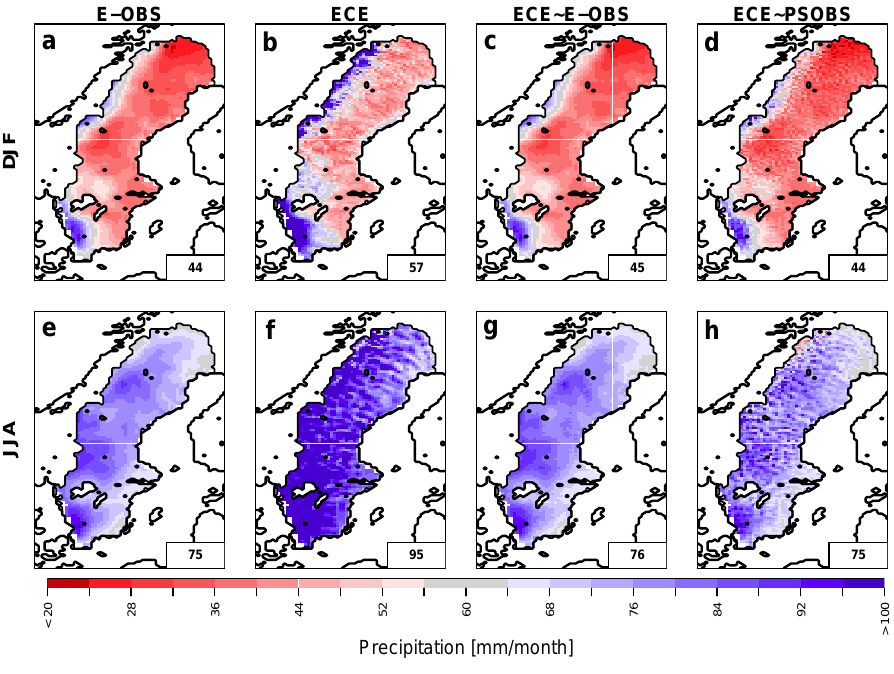
Figure 5. ( a–d ) Winter and ( e–h ) Summer Seasonal mean precipitation for (a,e) E-OBS, (b,f) ECE, (c,g) ECE ∼ E-OBS and (d,h) ECE ∼ PSOBS. The domain average value is given in the lower right box in each